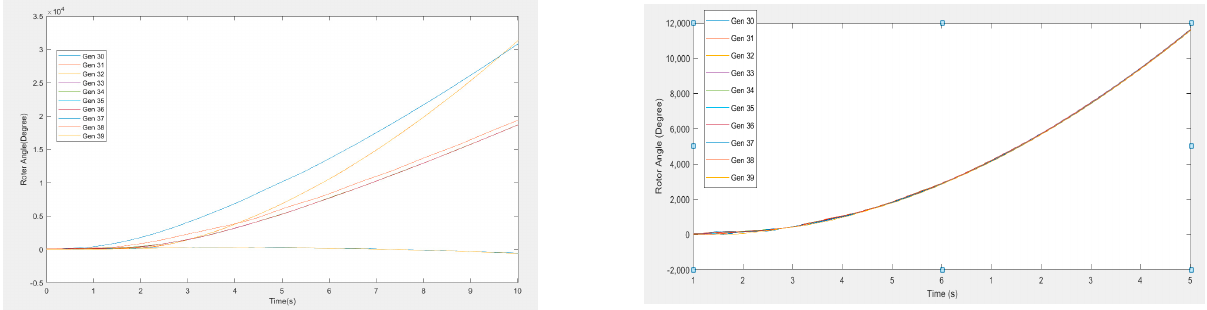
Figure 5. Comparison of rotor angle curve before and after collaborative transient stability control on fault lines 25 − 26 of IEEE 39 bus system.